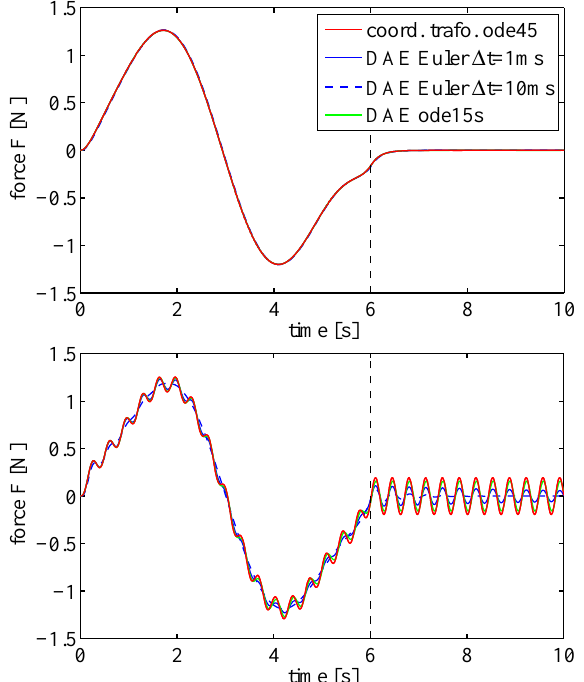
Figure 13. Mass on car – case 2, α = 5 ◦ : generalized velocities ˙ q With damping d = 1Nsm − 1 (top) and without damping